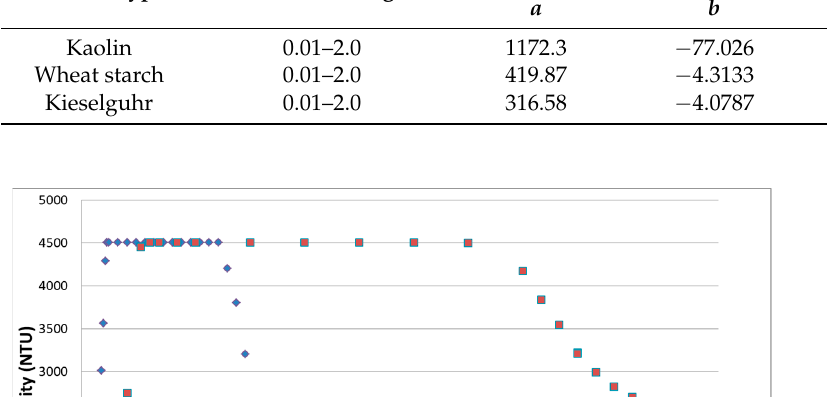
Table 2. Linear regression analysis of optical turbidity: T = aM + b .